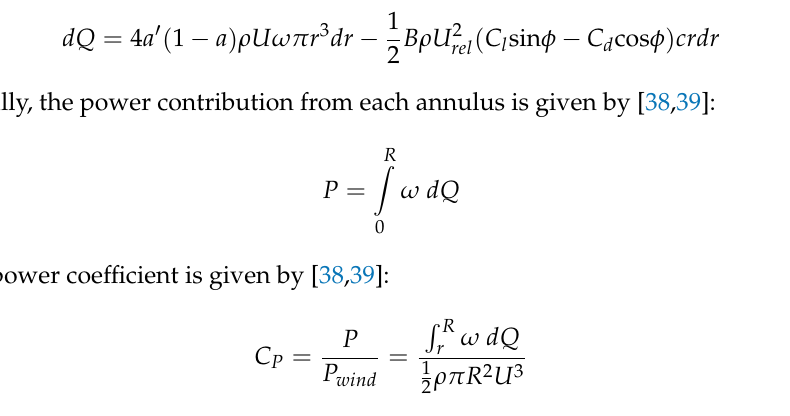
Figure 3. Blade Element Velocities and Forces. To determine the complete performance characteristics of a wind turbine requires an iterative solution which consists of initializing a and a (cid:48) to zero, assuming C d = 0. Drag is excluded from calculating the flow induction factors because drag in attached flows is caused by skin friction and does not affect the pressure drop across the rotor [39,40]. Once the induction factors have been obtained, φ , C l and C d are calculated, then the process is repeated until convergence is obtained. With the results for a , a (cid:48) , φ , C l and C d , the torque can be calculated by Equations (21) and (23):